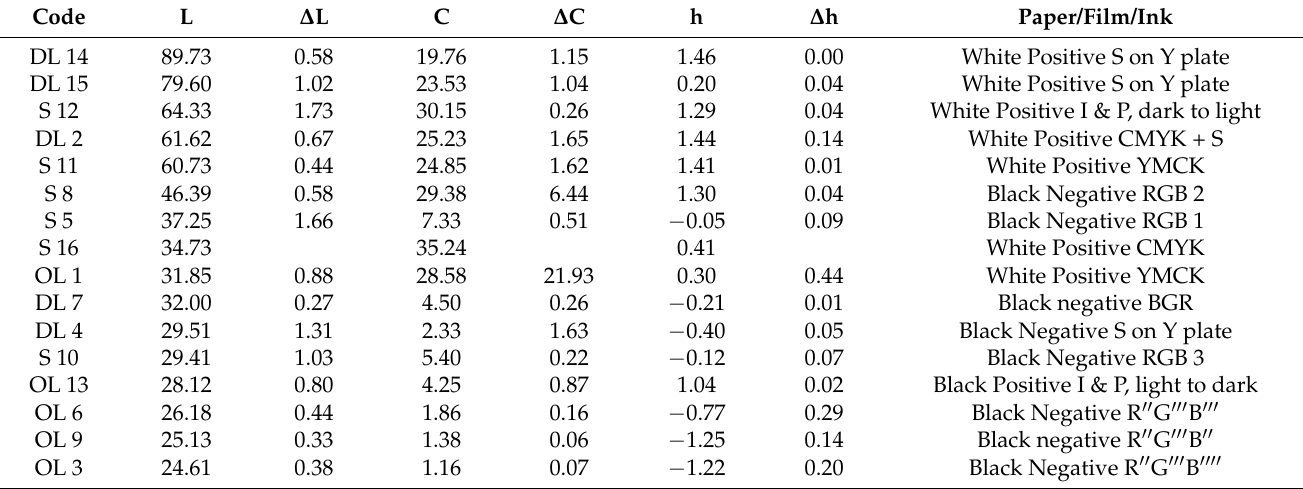
Table 11. Average luminosity, chroma and hue of all red spots. Ordered according to the higher luminosity